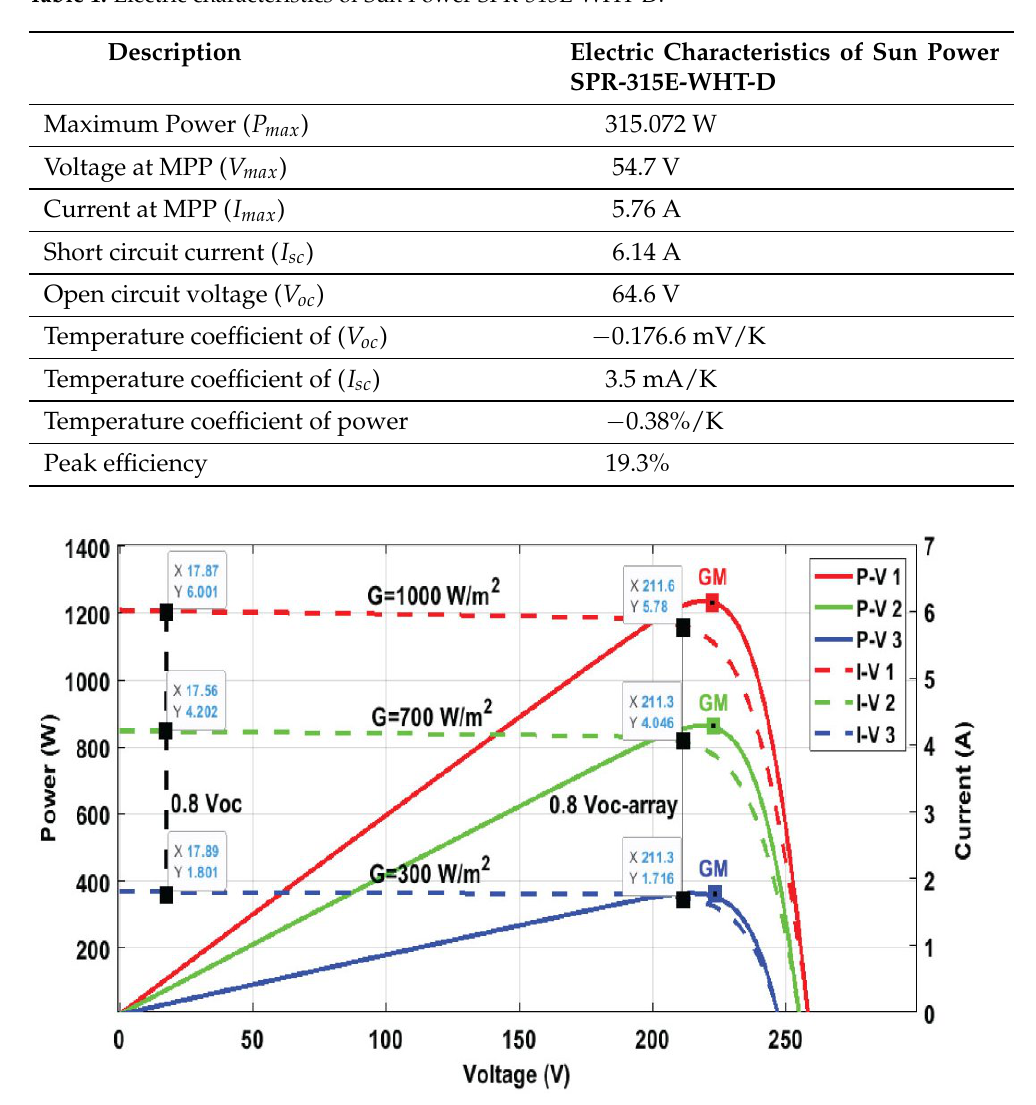
Table 1. Electric characteristics of Sun Power SPR-315E-WHT-D.